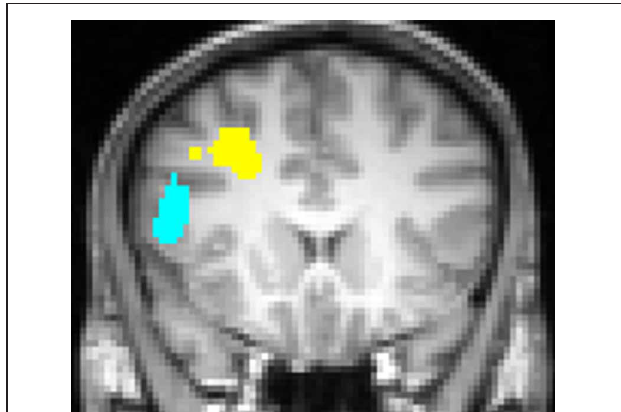
FIGURE 4 | Left inferior frontal gyrus (blue) region more active for negative words than for neutral words, significantly moreso for subjects scoring high in anxious apprehension, and left dorsolateral prefrontal cortex (yellow) region more active for positive words than for neutral words, with no differentiation by level of anxious apprehension or anxious arousal, displayed at Talairach y = 18. Neurological convention (left-hemisphere on left of panel). From Engels et al. (2007). Copyright the Society for Psychophysiological Research.